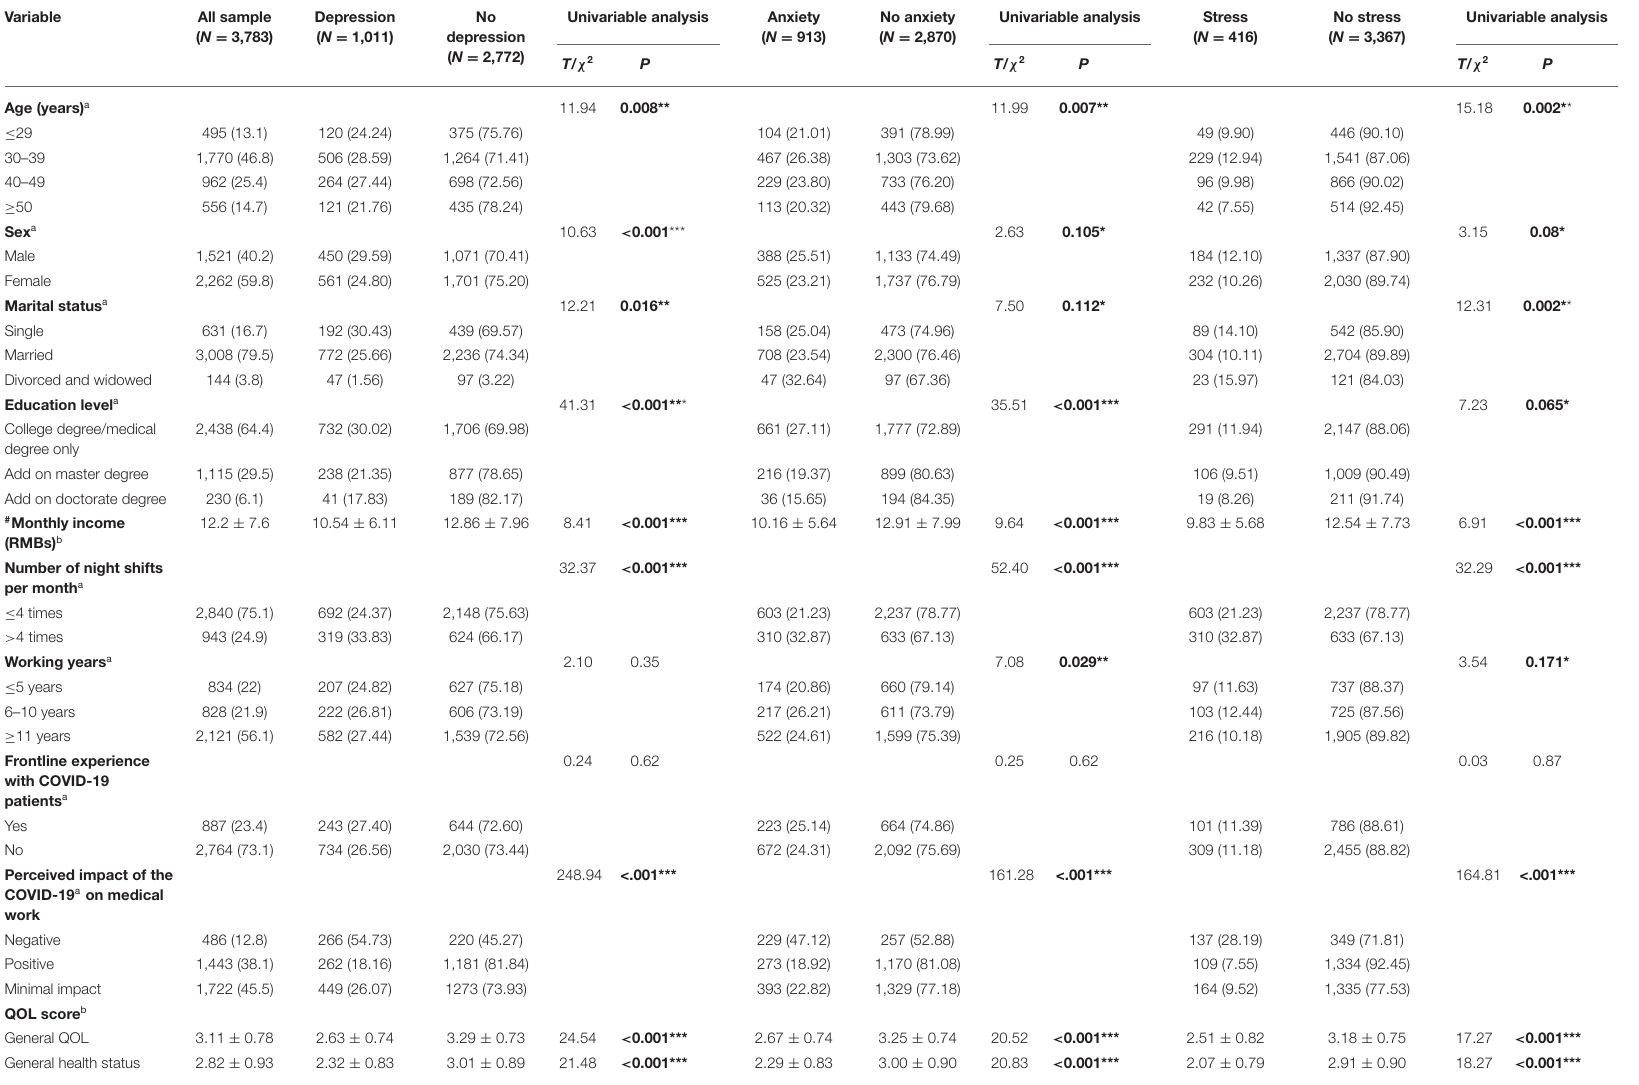
TABLE 1 | Basic features, occurrences of depressive, anxious and stress symptoms in 3,783 Psychiatrists in China.